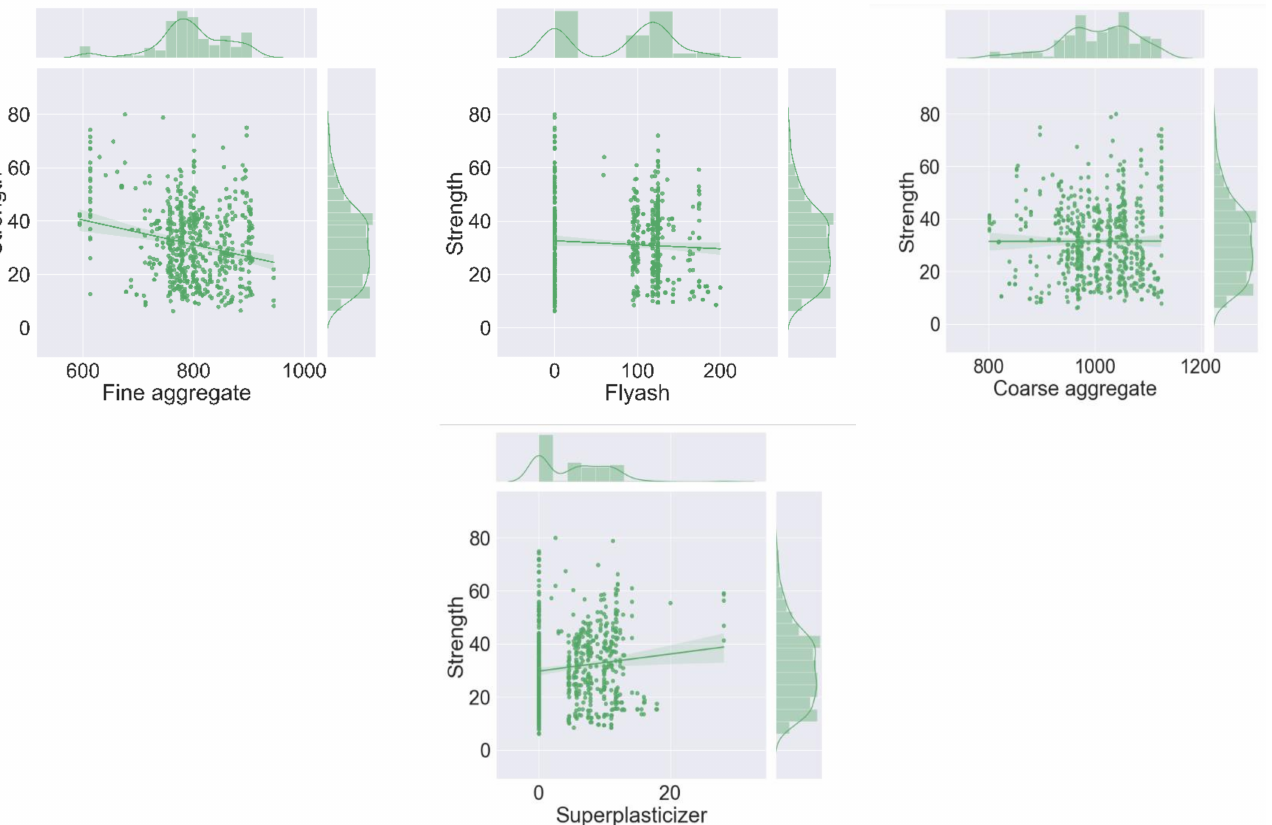
Figure 1. Reflection of histograms for inputs indicating the relative frequency distribution.